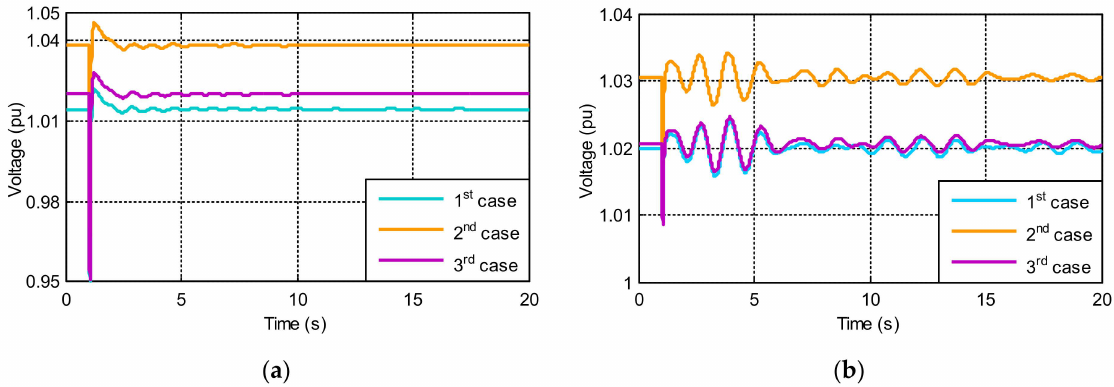
Figure 8. Voltage transient response of the power system versus line disturbance at different points: ( a ) voltage at bus no. 16840-GQD11; ( b ) voltage at bus no. 16227-YSP13.